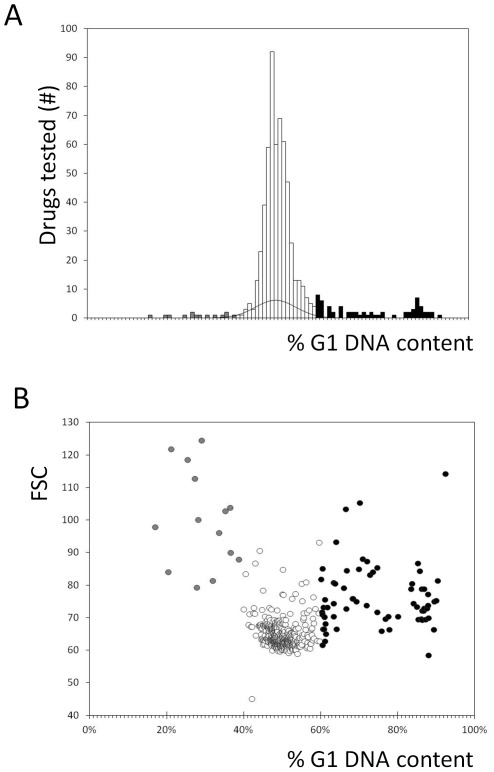
DNA content analysis identifies drug effects on cell cycle progression.A, Cumulative histogram displaying the percentage of cells in the G1 phase of the cell cycle (%G1), for cells treated with a panel of FDA-approved drugs. The bin width of the histogram is 1%, with each bin containing all the drugs with values within the bin boundaries. The black line superimposed to this histogram is the normal distribution fit of the %G1 values of the reference sample. Bins with values >2 sd from the mean of the wild type distribution are in grey (“Low G1” group) and black (“High G1” group). B, From all the samples we analyzed by flow cytometry, the %G1 is on the x-axis, and the forward angle scattering (FSC) values on the y-axis. We colored the data points of the sub-groups as in A.